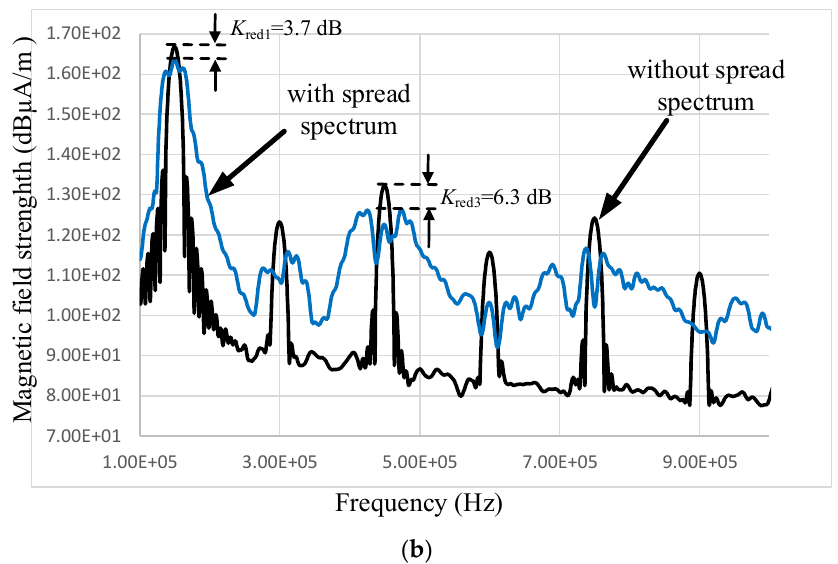
Figure 9. Comparison of spectra of radiated emissions from the WPT system without spread spectrum and with spread spectrum based on periodic SFM: ( a ) without SFM and with periodic SFM (sine modulation, f m = 10 kHz, ∆ f peak = 12 kHz; RBW = 1 kHz); ( b ) without SFM and with periodic SFM (sine modulation, f m = 10 kHz, ∆ f peak = 12 kHz; RBW = 10 kHz).